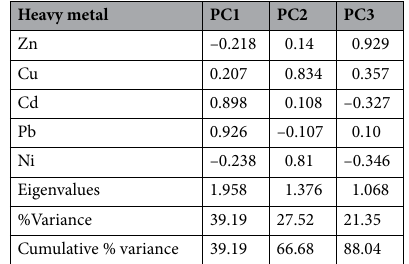
Table 7. Principal component analysis of heavy metals in the study